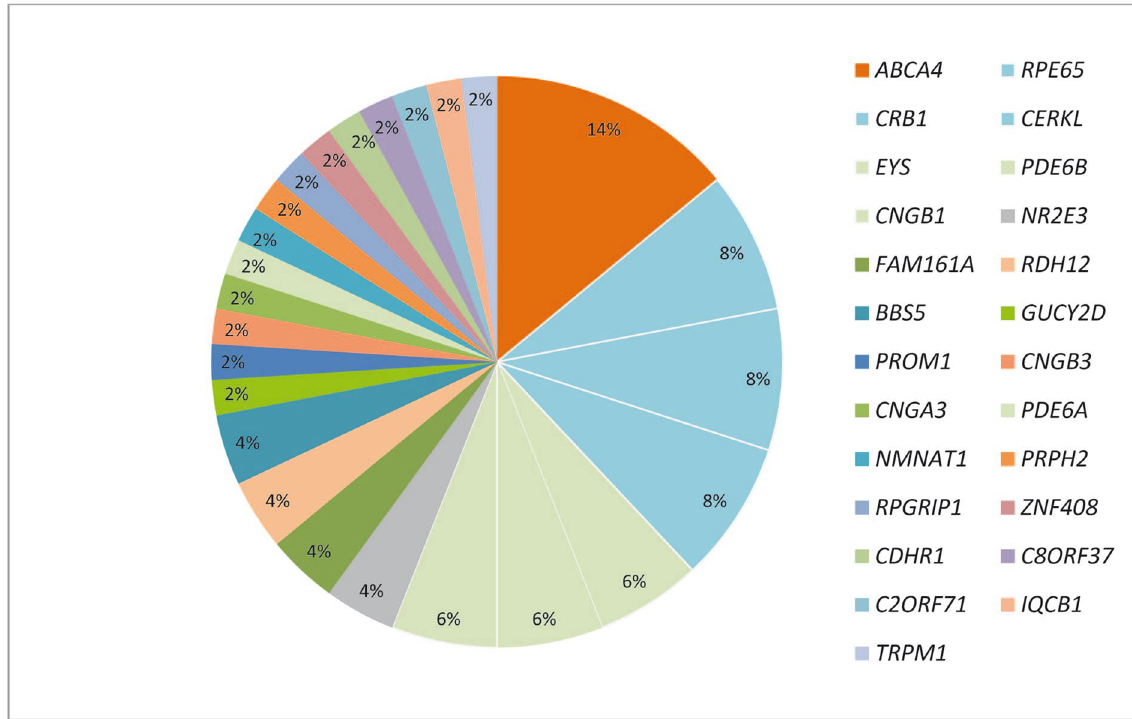
Figure 5. Mutational spectrum in 73 Tunisian cases with confirmed molecular